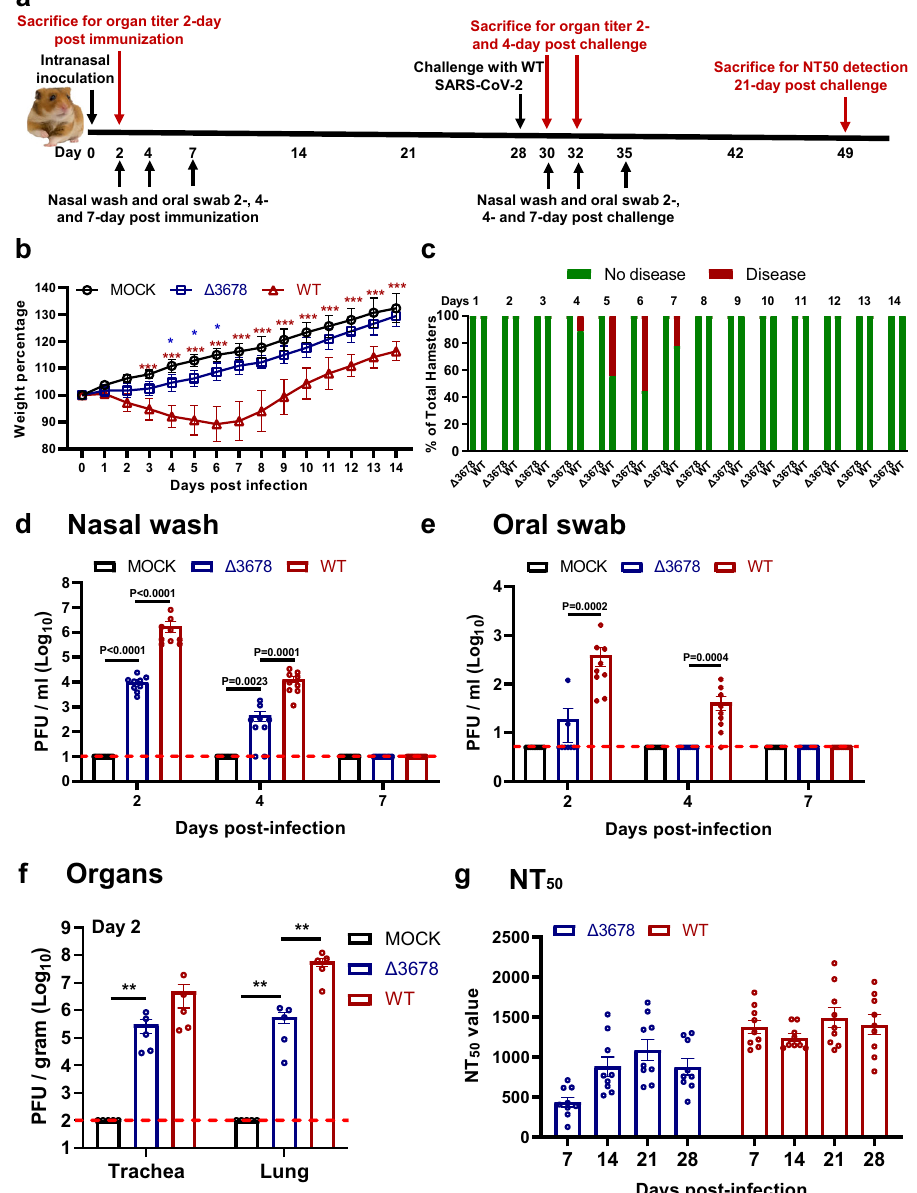
Fig.2|Attenuationof Δ 3678SARS-CoV-2inhamsters.a Experimentalschemeof Δ 3678 virus immunization and WT virus challenge. Hamsters were intranasally inoculated with 10 6 PFU of WT or Δ 3678 virus. On day 2 post-inoculation, organ viral loads ( n =5) were measured by plaque assays. Nasal washes and oral swabs ( n =10) were collected on days 2, 4, and 7 post-inoculation. On day 28 post- immunization, the hamsters were challenged by 10 5 PFU of WT SARS-CoV-2. On days 2 and 4 post-challenge, plaque assays were performed to measureorganviral loads ( n =5). On day 21 post-challenge, the animals were terminated to measure neutralization titer (NT 50 ). b Weight changes of hamsters after intranasal infection with WT ( n =9) or Δ 3678 ( n =9) SARS-CoV-2. Uninfected mock group ( n =9) was included as a negative control. Body weights were measured daily for 14 days. The data are shown as mean±standard deviation. The weight changes between Δ 3678 and mock or WT groups were analyzed using two-factor analysis of variance (ANOVA) with Tukey ’ s post hoc test. The blue and red asterisks stand for the